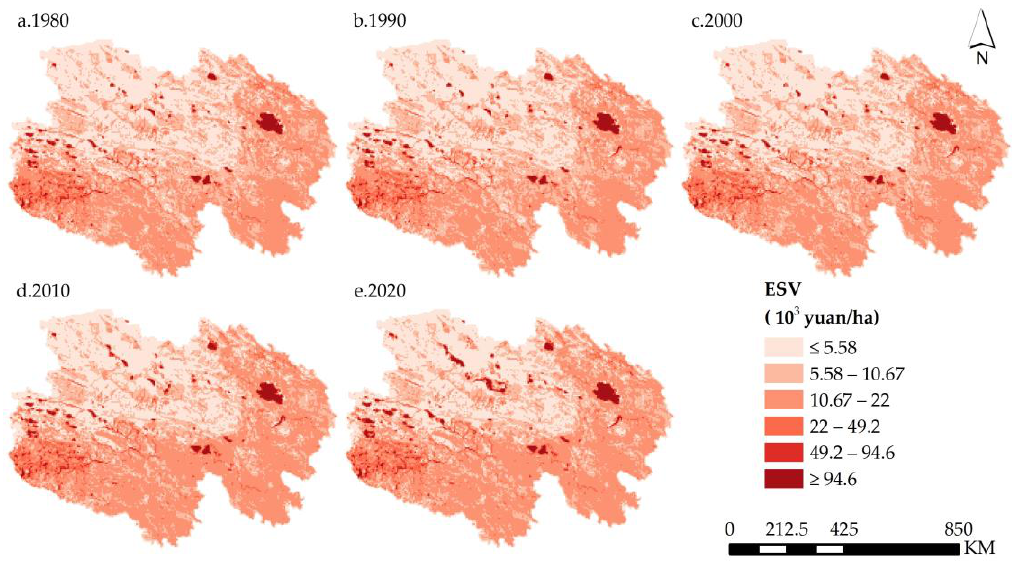
Figure 4. Spatial distribution of ESV in Qinghai Province from 1980 to 2020 (10 3 ¥/ha). The value of farmland in the Sanjiangyuan EFZ grew the fastest (19.1%), followed by the value of water (13.43%), while the value of barren land, glacier and snow, and forest showed declines (−20.11%, −0.96% and −0.4%). The value of glacier and snow in Qilian Mountains EFZ grew the fastest (90.52%) but declined after 2010, due to the ef- fects of climate change. The grassland value of Qinghai Lake EFZ grew the fastest (20.19%). The value of water and farmland in Qaidam EFZ grew the fastest (98.71% and 46.49%, respectively); however, other land types showed a decline in value (−5.34% , −1.94% , −1.7% , and −0.41% ). Table 2. ESV changes of five ecological function zones of during 1980 to 2020.